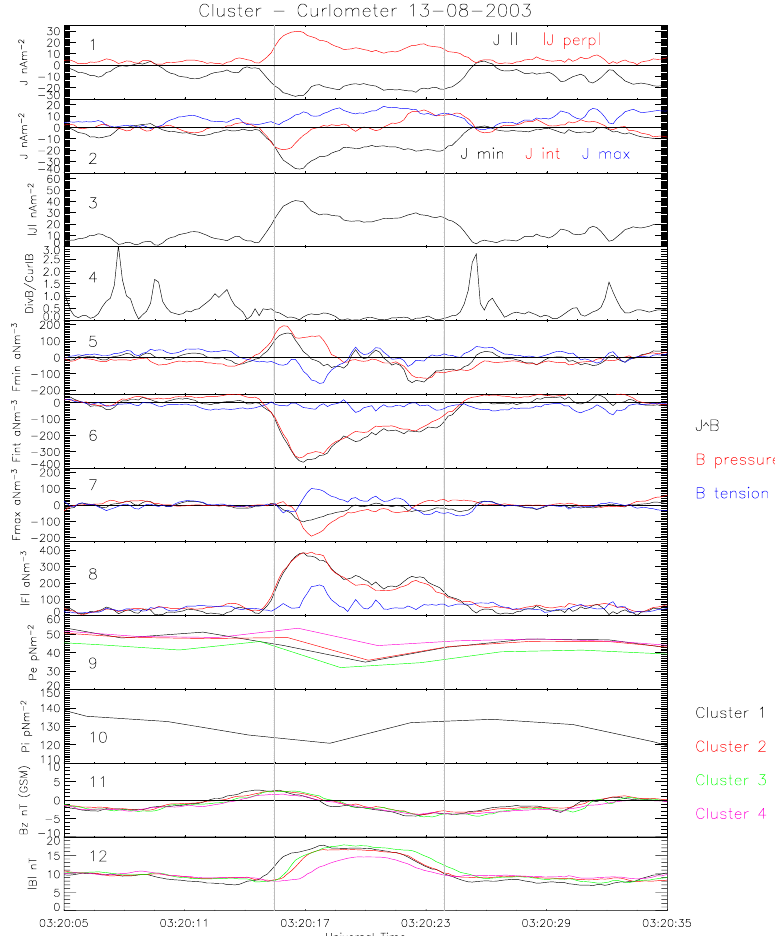
Fig. 14. Curlometer results from 13 August event in the same format as Fig.